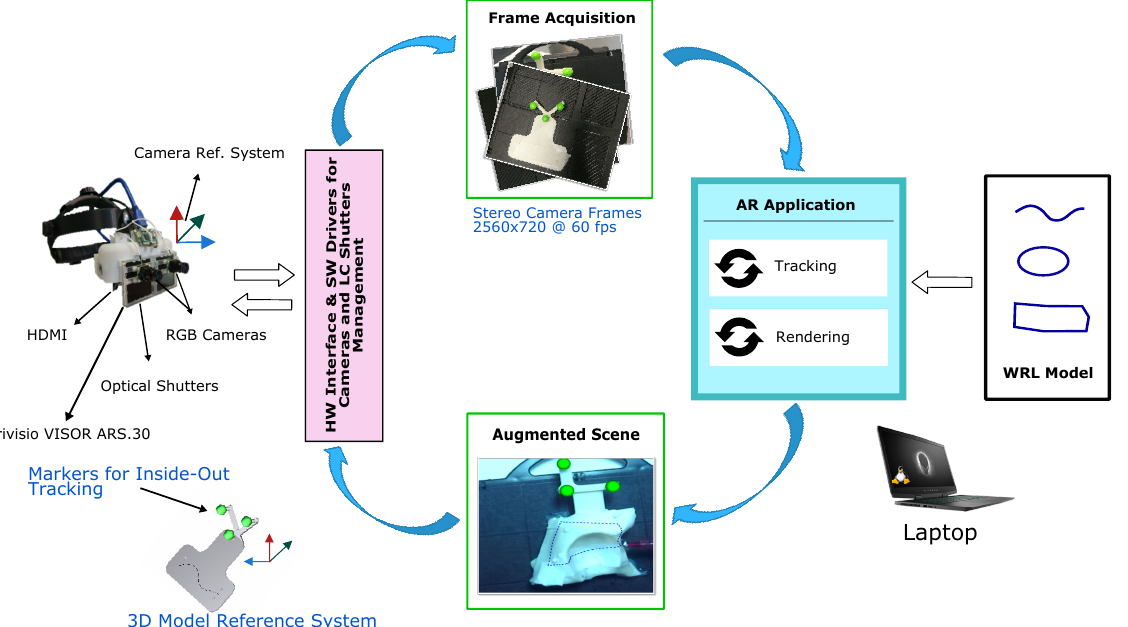
Figure 1. Overview of the hardware and software components of the wearable Augmented Reality (AR) platform for aiding high-precision manual tasks in the peripersonal space. The AR framework runs on a single workstation (i.e., a laptop) and can implement both the optical see-through (OST) and the video see-through (VST)